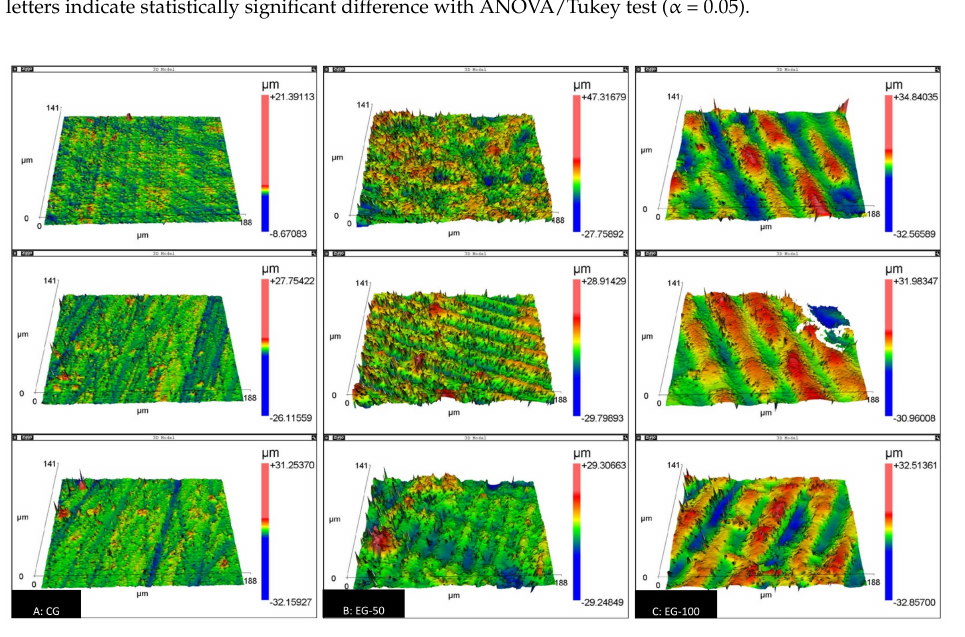
Figure 4. Three-dimensional surface-morphology images obtained with a scanning white-light interferometer (scan area: 40 µ m 2 ) ( A ): CG, auto-polymerizing acrylic resin; ( B ): EG-50, VP resin printed with 50 µ m resolution; ( C ): EG-100, VP resin printed with 100 µ m